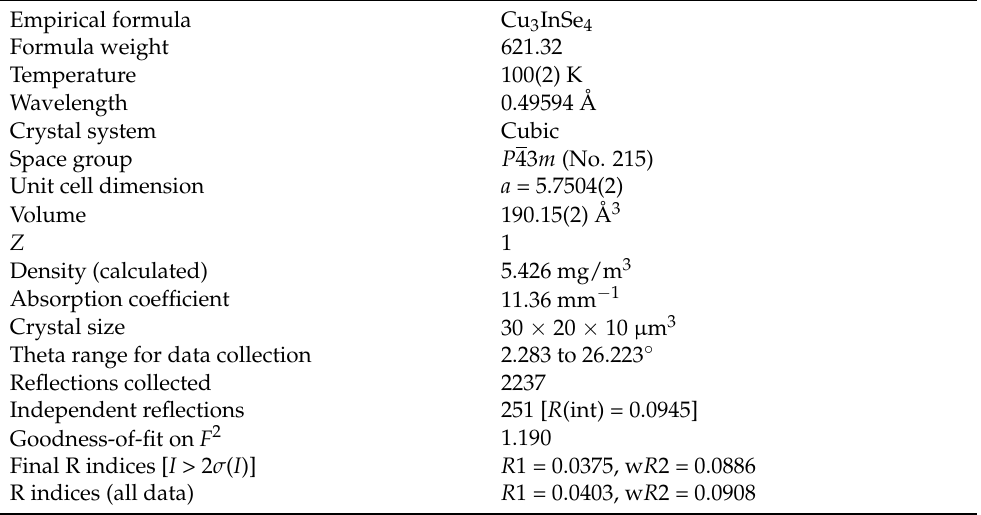
Table 1. Crystal data and structure refinement results.